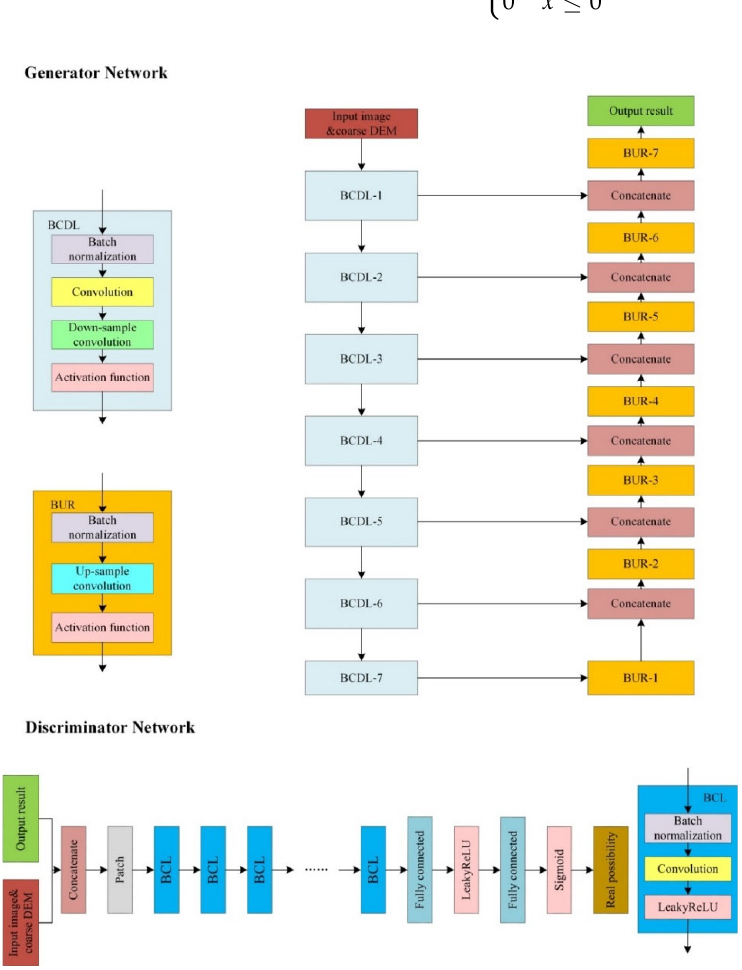
Figure 2. Schematic diagram of the LDEMGAN structure.